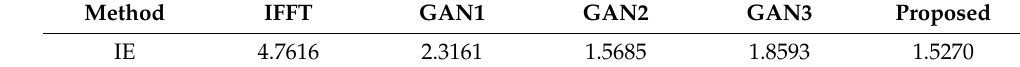
Figure 9. Imaging results of Yak42 at SNR = 2 dB: ( a ) IFFT; ( b ) GAN1; ( c ) GAN2; ( d ) GAN3; ( e ) Proposed GAN.